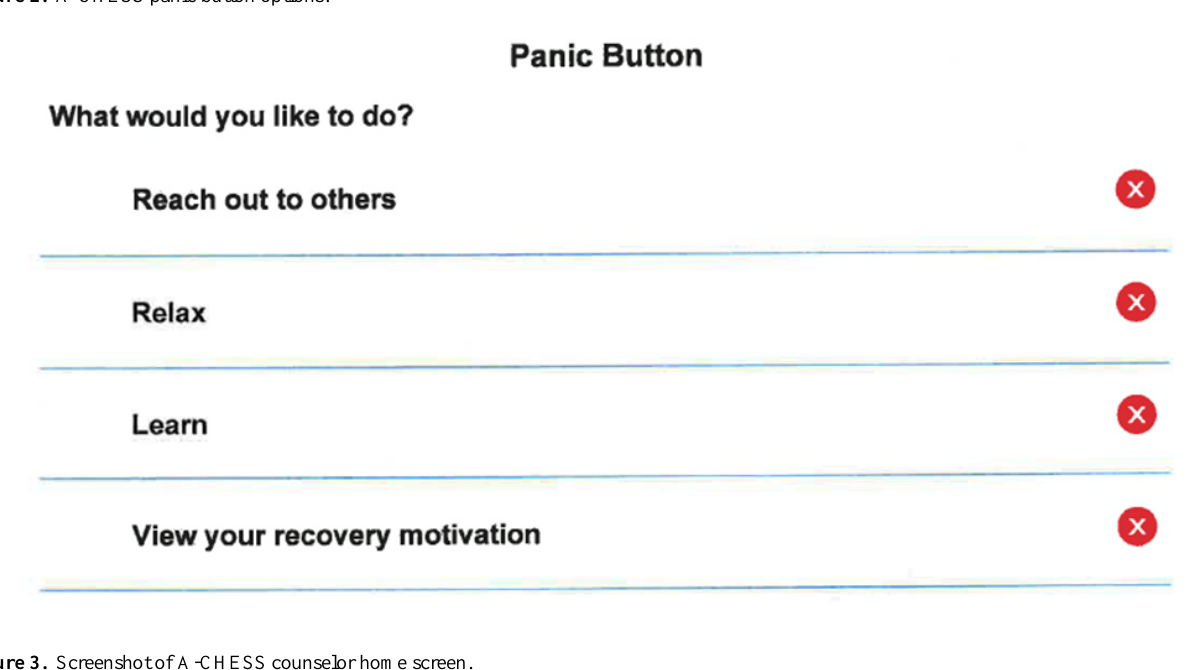
Figure 2. A-CHESS panic button options.